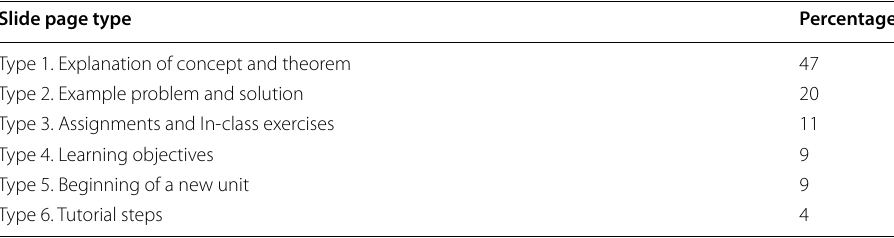
Table 4 Six slide types that students frequently jump back to Slide page type Percentage